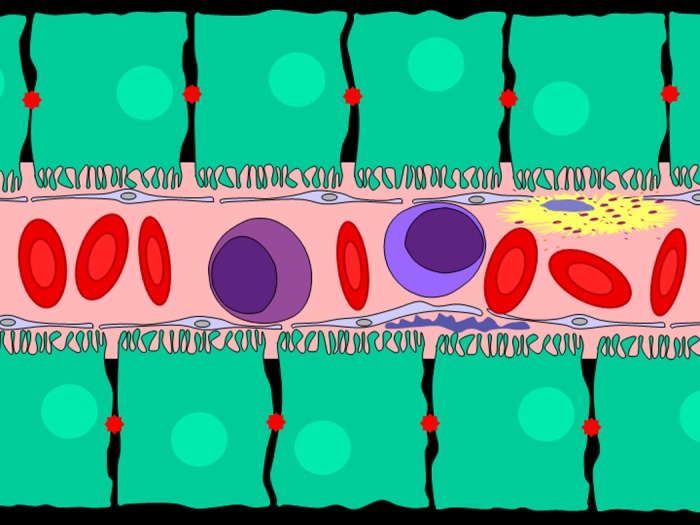
Tracking the movment of glowing T cells in the vasculature